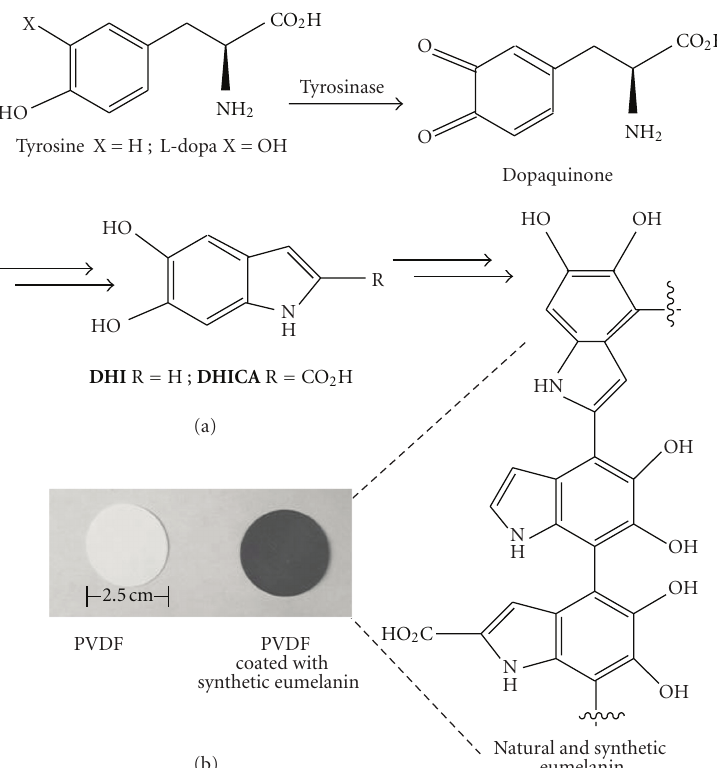
Figure 1: (a) Biosynthesis of natural eumelanin and biomimetic production of synthetic eumelanin. (b) 2.5cm PVDF disc before (left) and after (right) coating with synthetic